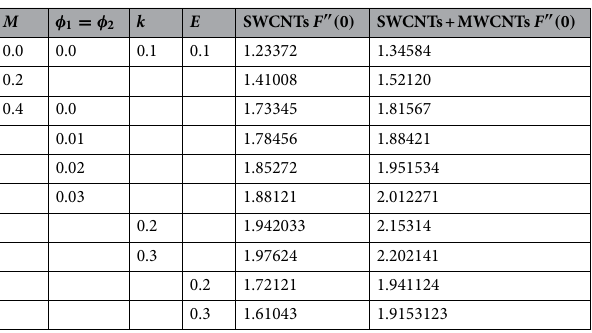
Table 1. Skin friction C fx Re